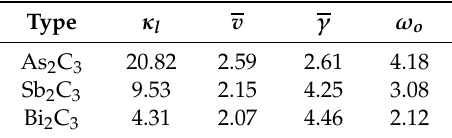
Figure 4. ( a ) Calculated lattice thermal conductivity of M 2 C 3 versus temperature. ( b ) Phonon group velocity, ( c ) Grüneisen parameters, and ( d ) phonon relaxation time versus frequency for M 2 C 3 , respectively. Table 2. Summary of the lattice thermal conductivity κ l (W / mK), the averages of the acoustic group velocity v (km / s) and Grüneisen parameters γ , and the lowest optical frequency ω o (THz) for the As 2 C 3 , Sb 2 C 3 , and Bi 2 C 3 , respectively.